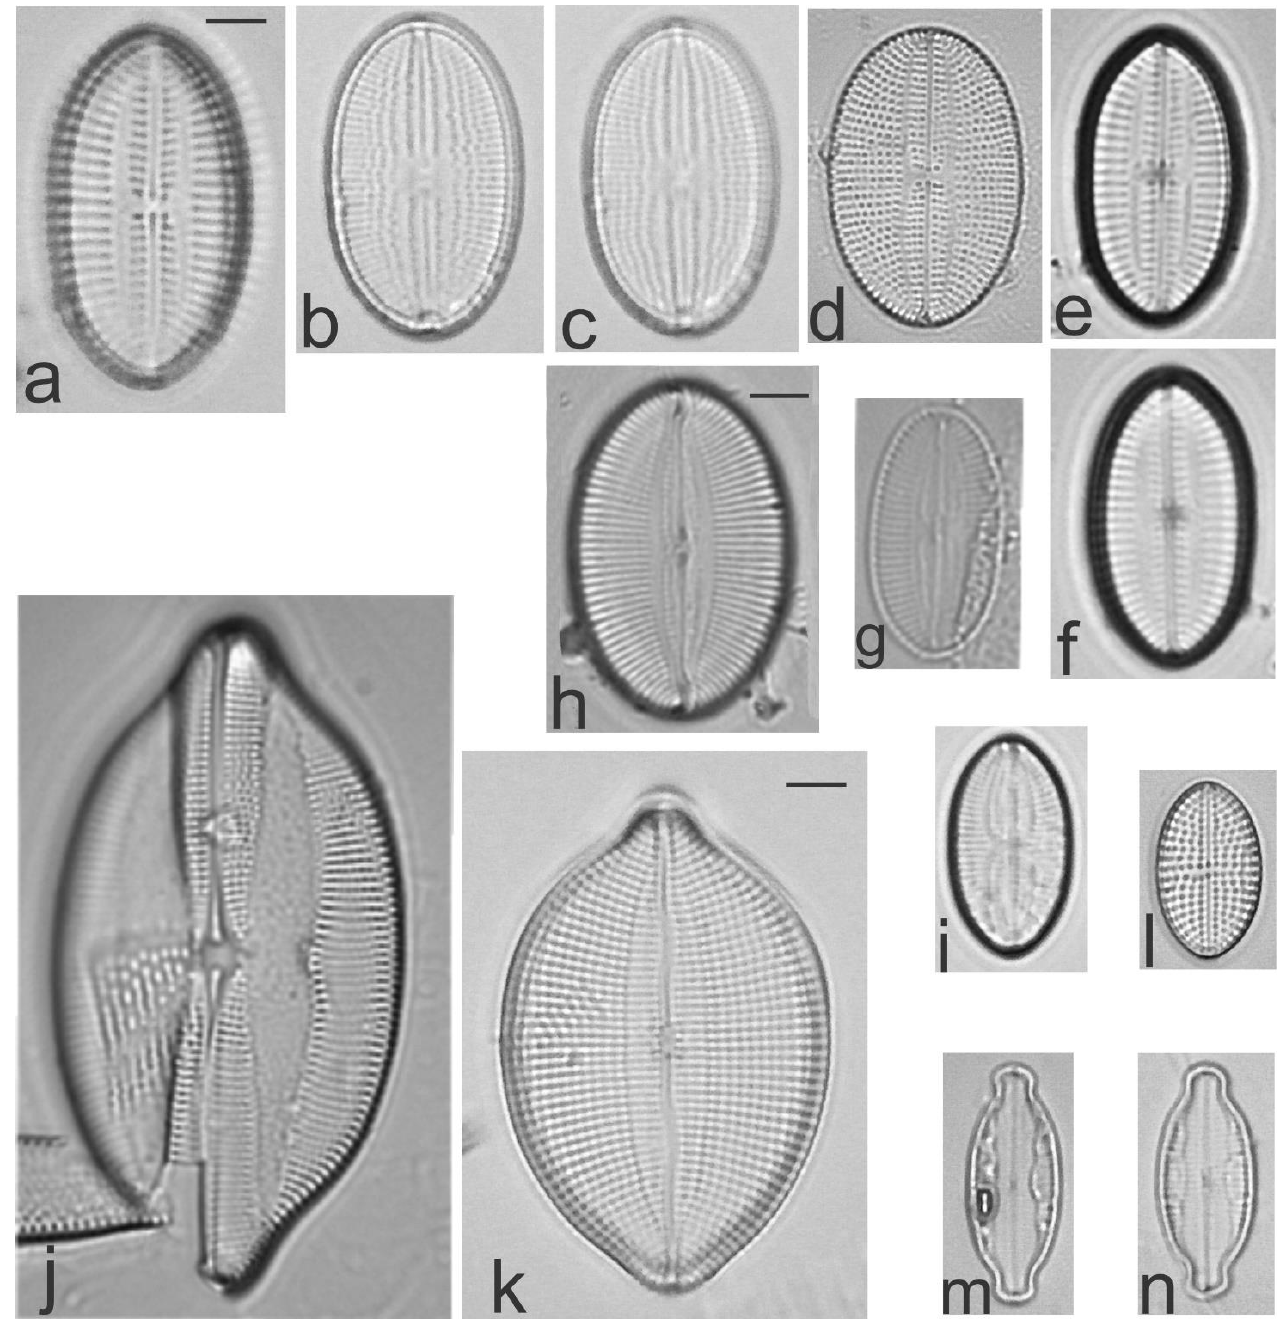
Figure 17. ( a , e , f ) Lyrella abrupta ; ( b , c ) Navicula sparsistriata ; ( d ) Lyrella rudiformis ; ( g ) Fallacia oculiformis ; ( h ) Fallacia ny ; ( i ) Fallacia forcipata ; ( j ) Navicula ( Lyrella ) clavata var. proxima ; ( k ) Mastogloia peragalli ; ( l ) Mastogloia ovalis ; ( m , n ) Mastogloia manokwariensis . Scale bars = 5 μm.